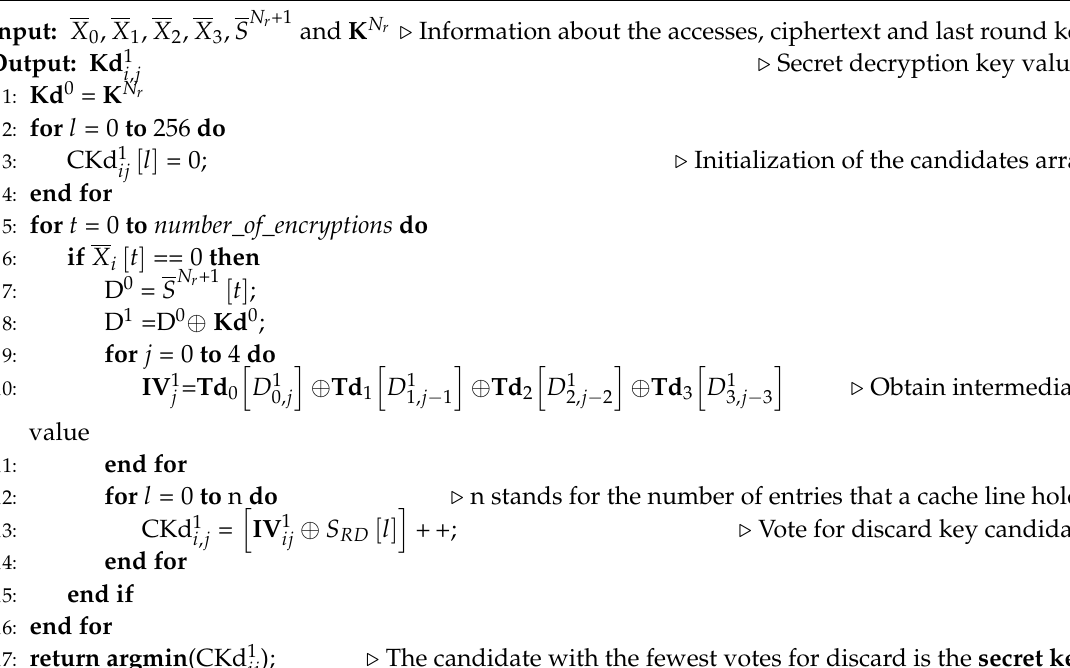
Algorithm 3 Recovery algorithm for key byte Kd 1